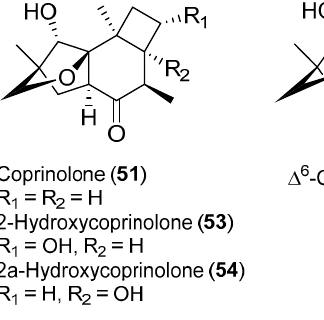
Figure 11. Structures of coprinolones 51 – 56 isolated from the Coprinus and Granulobasidium genera of fungi.